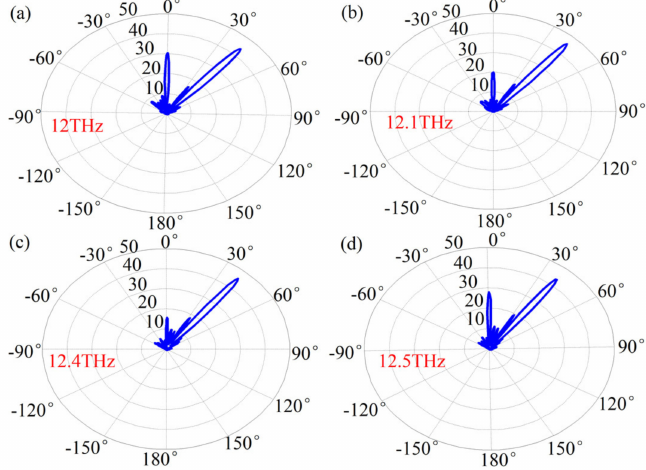
Figure 5. Broadband performances of single-beam directional radiation. The far-field distributions of the electric field at the frequencies of ( a ) 12 THz, ( b ) 12.1 THz, ( c ) 12.4 THz, and ( d ) 12.5 THz. The unit is